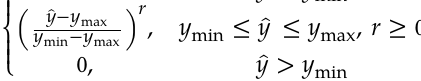
Table 4: The individual desirability